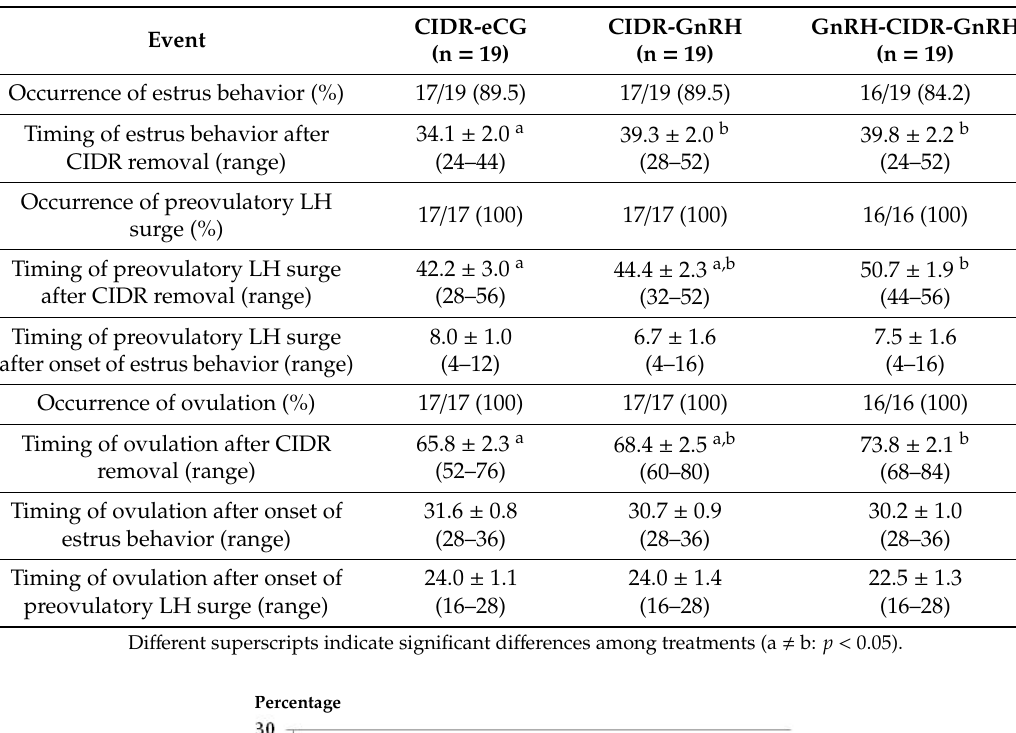
Table 1. Percentage and timing of occurrence (hours ± SEM) of estrus behavior, preovulatory luteinizing hormone (LH) surge, and ovulation in ewes treated with a single i.m. dose of 400 IU of eCG at CIDR removal (group CIDR-eCG), with a single dose of GnRH at 56 h after CIDR removal (group CIDR-GnRH), and with two GnRH doses—one at CIDR insertion and one 56 h after CIDR removal (group GnRH-CIDR-GnRH).